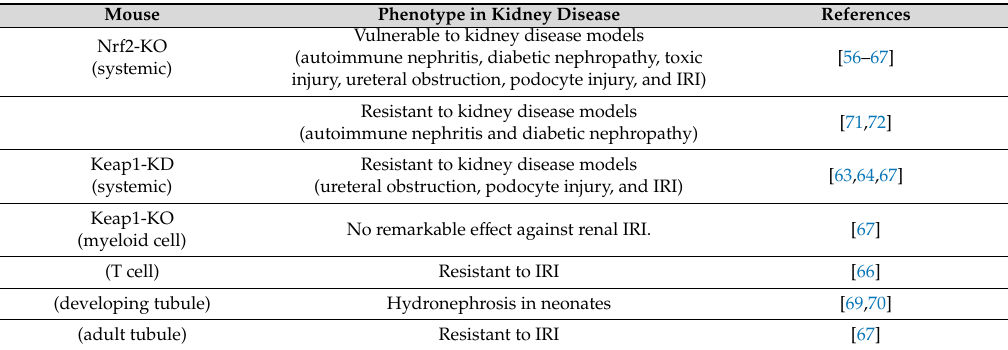
Table 1. Summary of mouse genetic analyses elucidating the roles of the Keap1-Nrf2 system in kidney